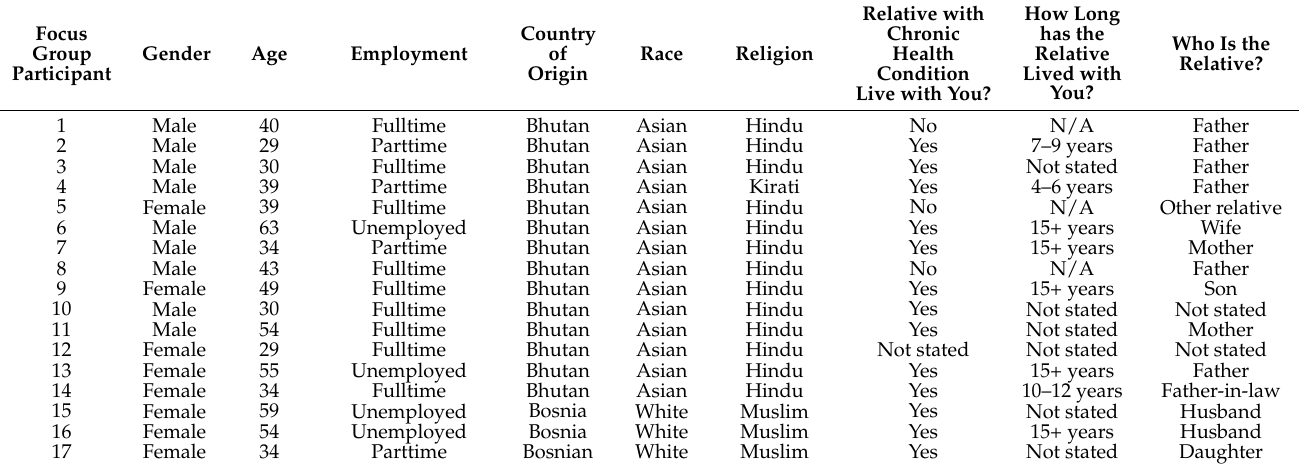
Table 1. Demographic characteristics of focus group participants.